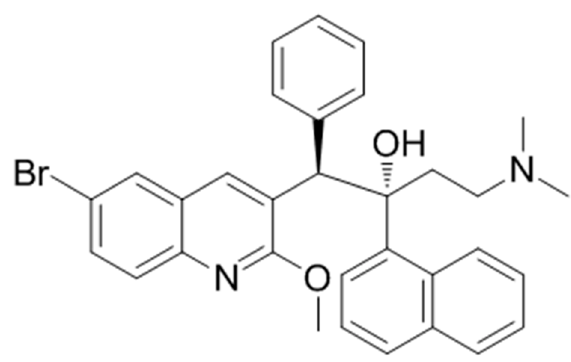
Figure 1. Chemical structure of bedaquiline (BDQ).